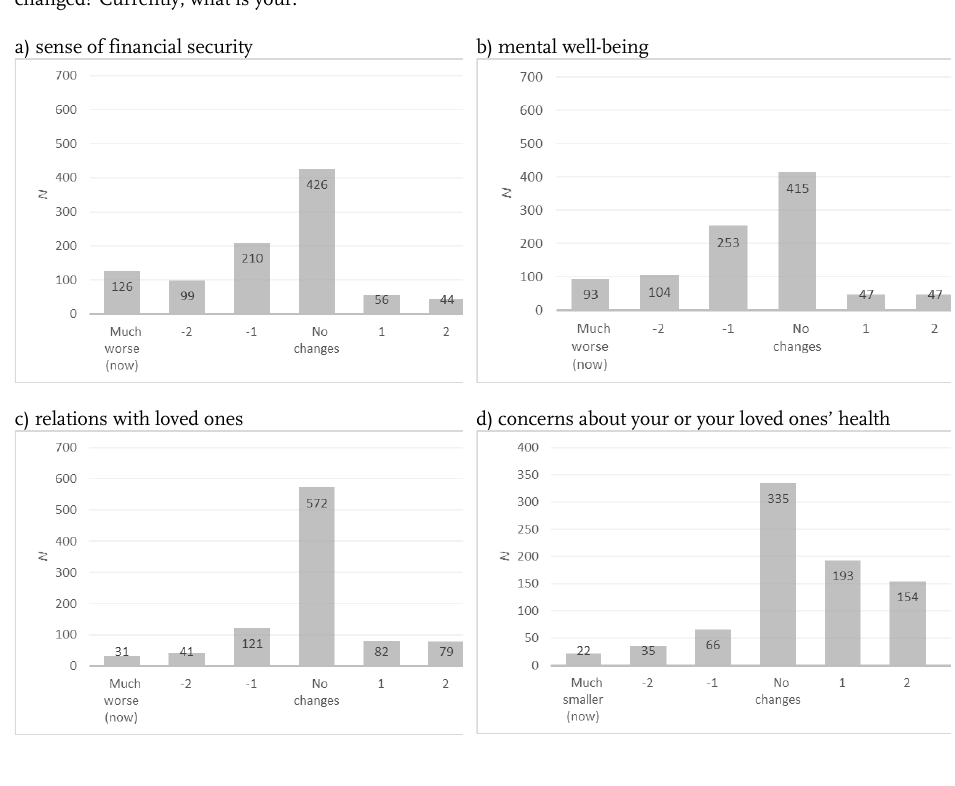
Figure A.1 : Frequency distributions of the perceived effects of the pandemic on respondents’ life (n=1,000) Compared to the situation before the outbreak of the pandemic, how have the following aspects of your life changed? Currently, what is